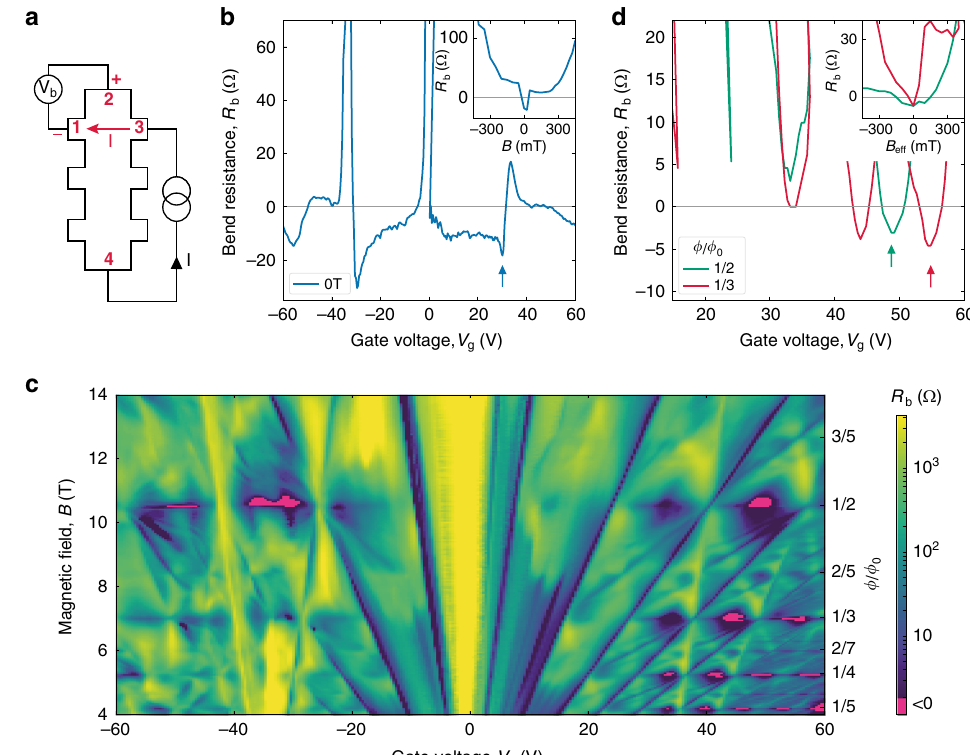
Fig. 2 Ballistic transport of BZ fermions over micrometer distances. a Schematic of bend resistance measurements. Current I is applied between contacts 3 and 4, and voltage V b is measured between 2 and 1, yielding the bend resistance, R b = V b / I . The voltage is positive for diffusive transport but becomes negative, if charge carriers move directly from current injecting contact 3 into voltage probe 1 (as shown by the red arrow). b Bend resistance for Dirac fermions in zero B (device D2 with W = 4 μ m and θ ≈ 0°). Inset: R b ( B ) taken at the minimum indicated by the arrow in the main plot. c Map R b ( V g , B ) for the same device. B was changed in steps of 50 mT. Pockets of negative R b appear along ϕ / ϕ 0 = 1/ q and are seen in magenta. d Cross-sections from ( c ) for q = 2 and 3. The inset shows sign reversals in R b plotted as a function of B eff = B – B p/q for the minima marked by the color-coded arrows. T = 2 K for all the